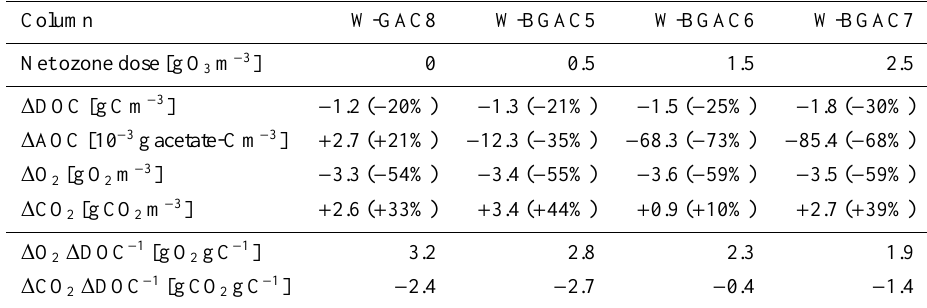
Table 3. Biological conversions in (B)GAC pilot filters. Column W-GAC8